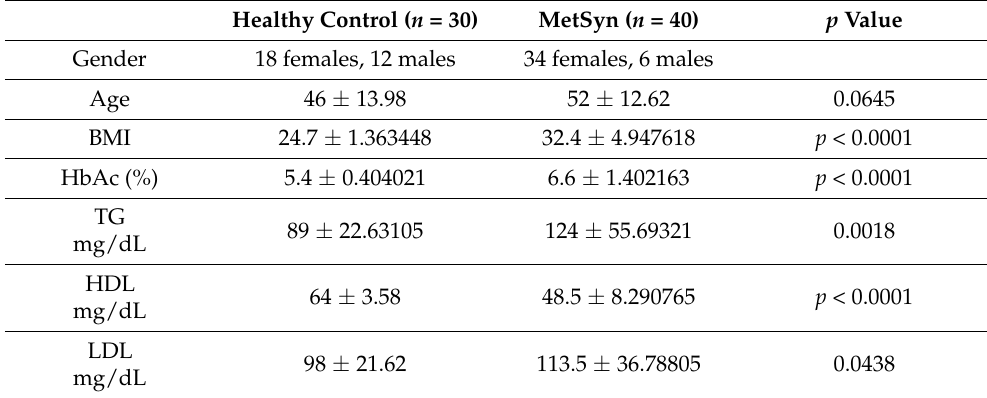
Table 1. Patient